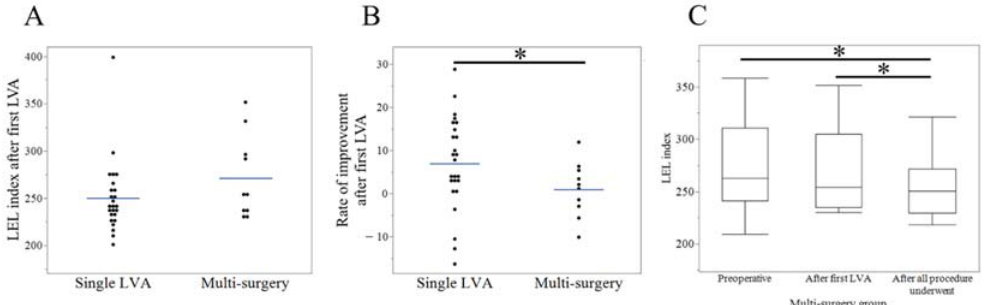
Figure 8. Comparison and results between the single LVA and multi surgery group. Comparison of the lower extremity lymphedema (LEL) index ( A ) and rate of improvement ( B ) after first the LVA between the single LVA and multi-surgery groups. ( C ). The LEL index decreased after all the procedures were performed in the multi-surgery group. * p < 0.05.